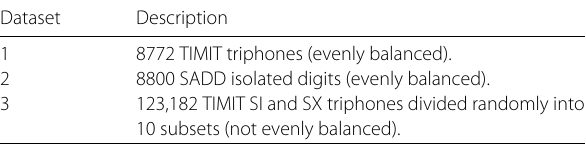
Table 1 Datasets used for experimental evaluation Dataset